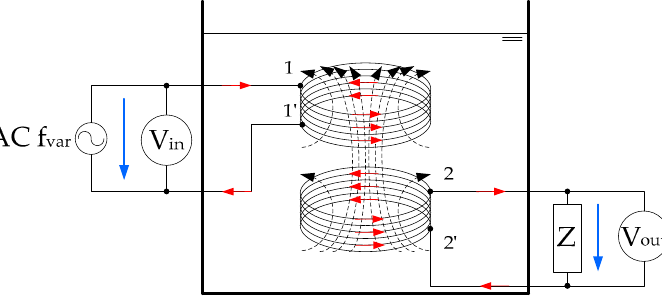
Figure 1. Fluid core dual-coil sensor, magnetic flux scheme.